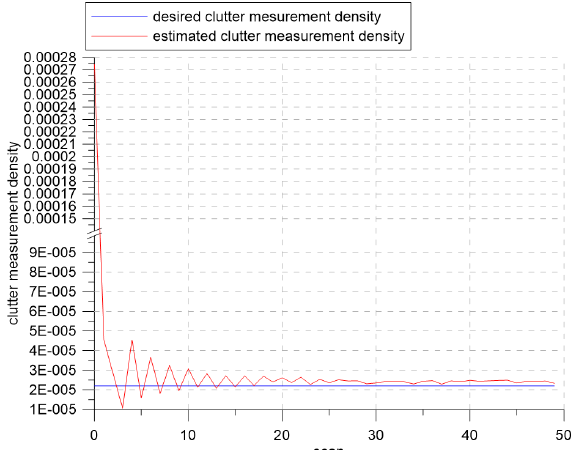
Figure 11. The desired clutter measurement density and estimated clutter measurement density for λ = 0.8.